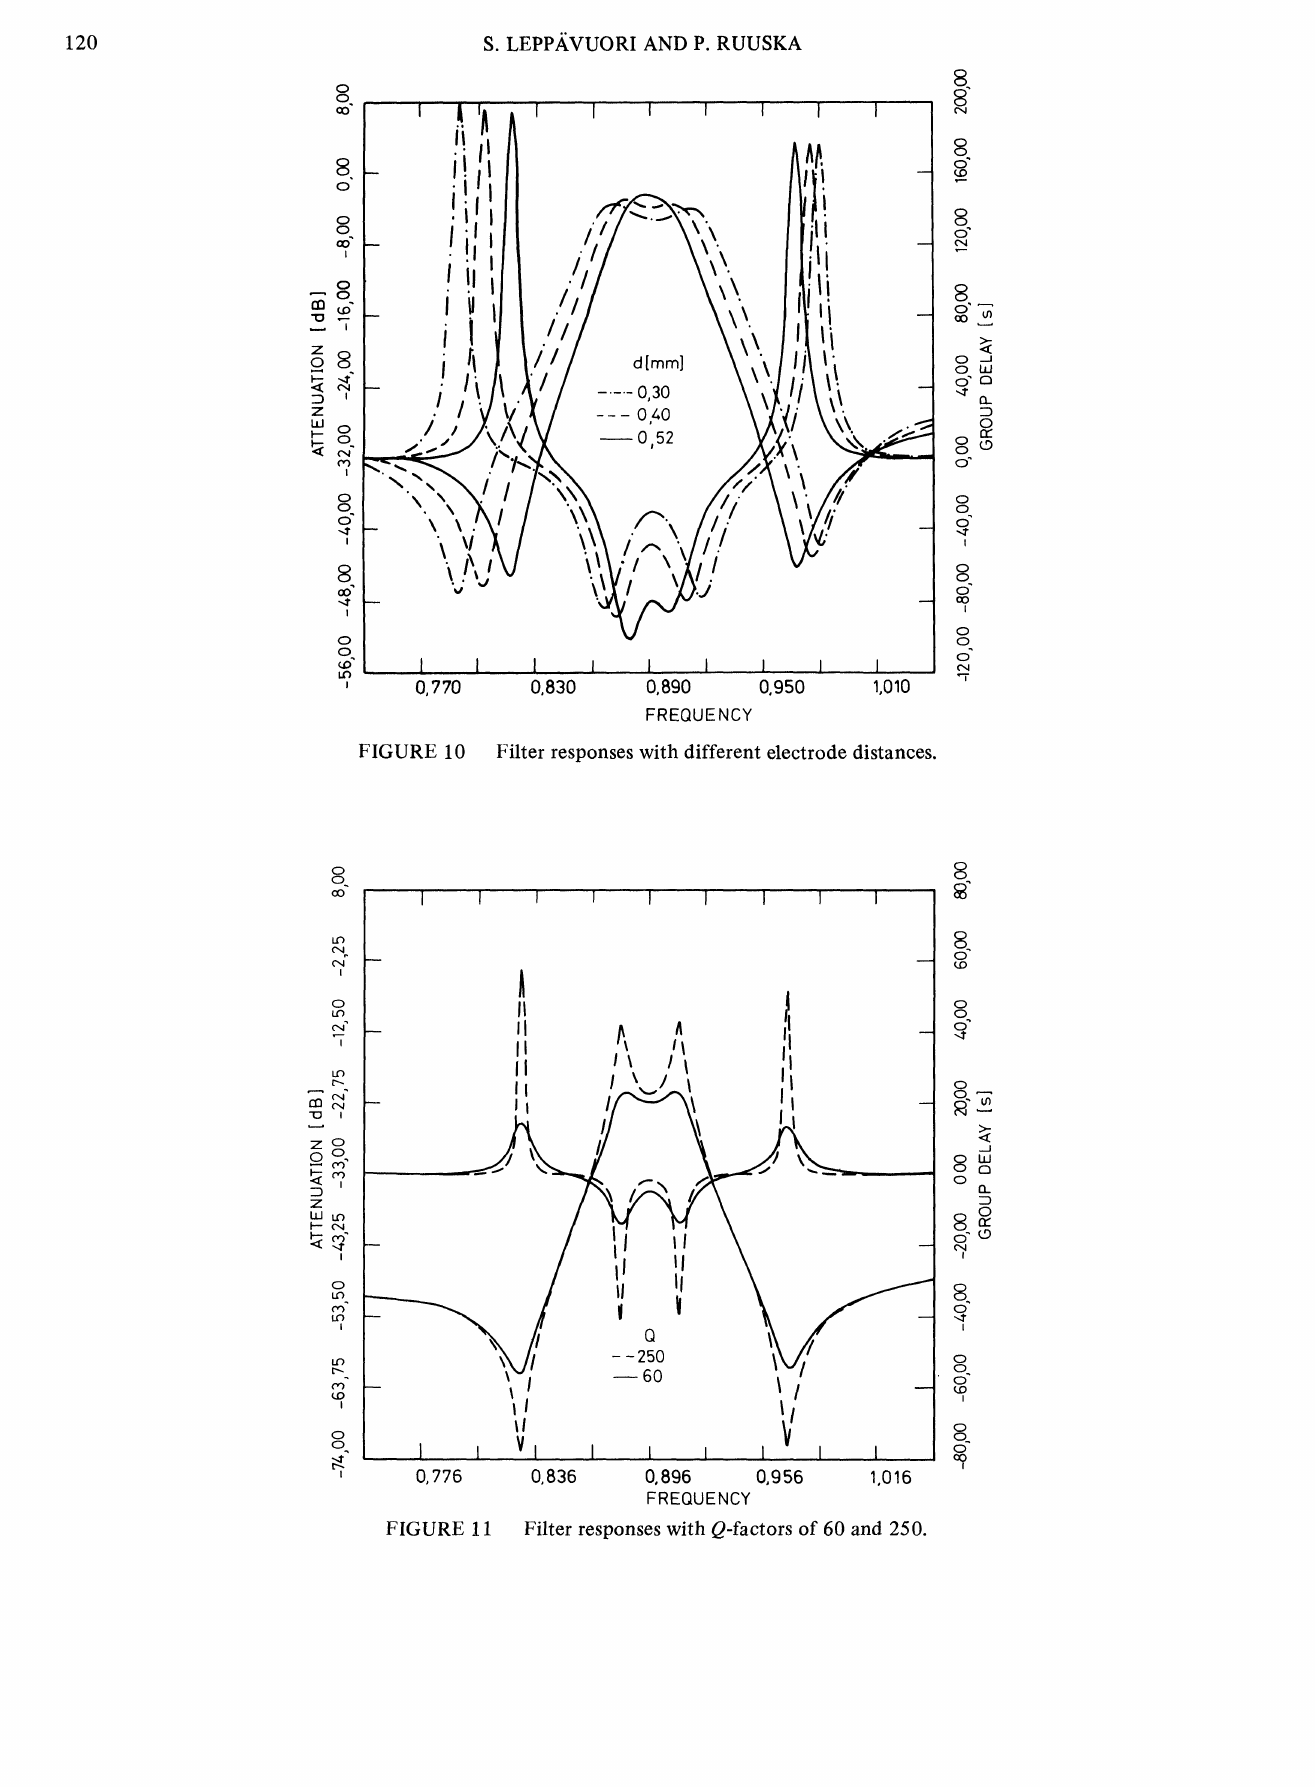
FIGURE 10 Filter responses with different electrode distances.